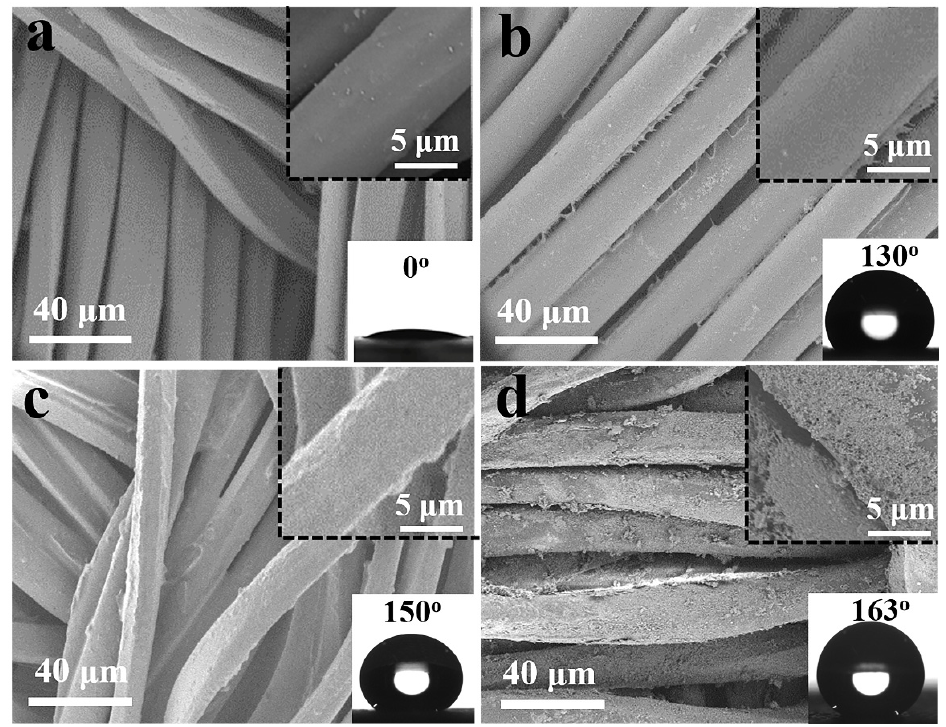
Figure 2. Scanning electron microscopy (SEM) images of the fabrics: ( a ) pristine fabric, ( b ) PDMS- coated fabric, ( c ) PDMS/STA-coated fabric, and ( d ) PDMS/STA/SiO 2 -coated fabric. Insets are differently magnified SEM images and WCAs of corresponding fabrics.